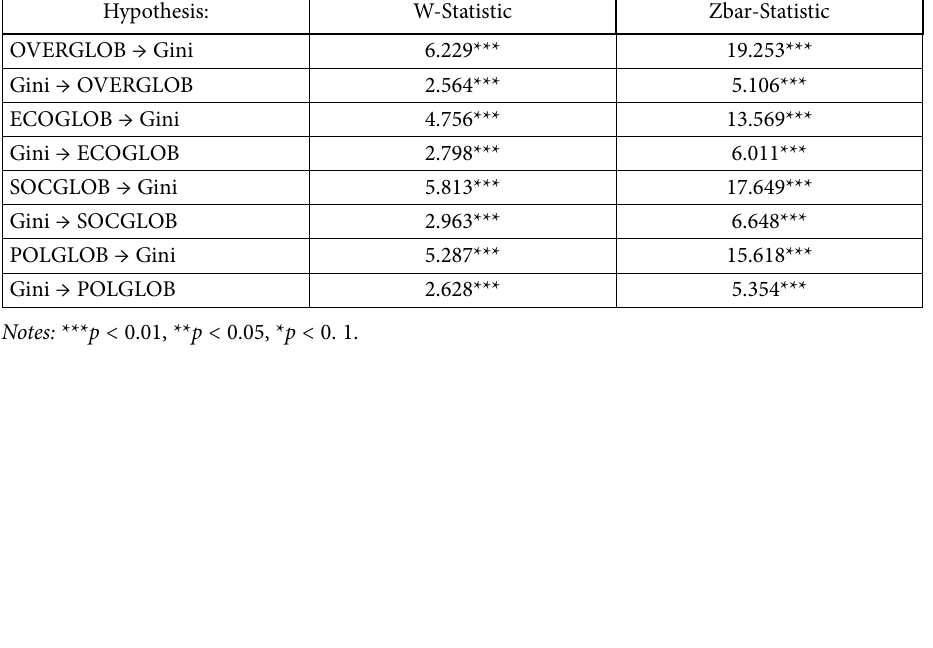
Table A6. Dumitrescu-Hurlin Granger causality test